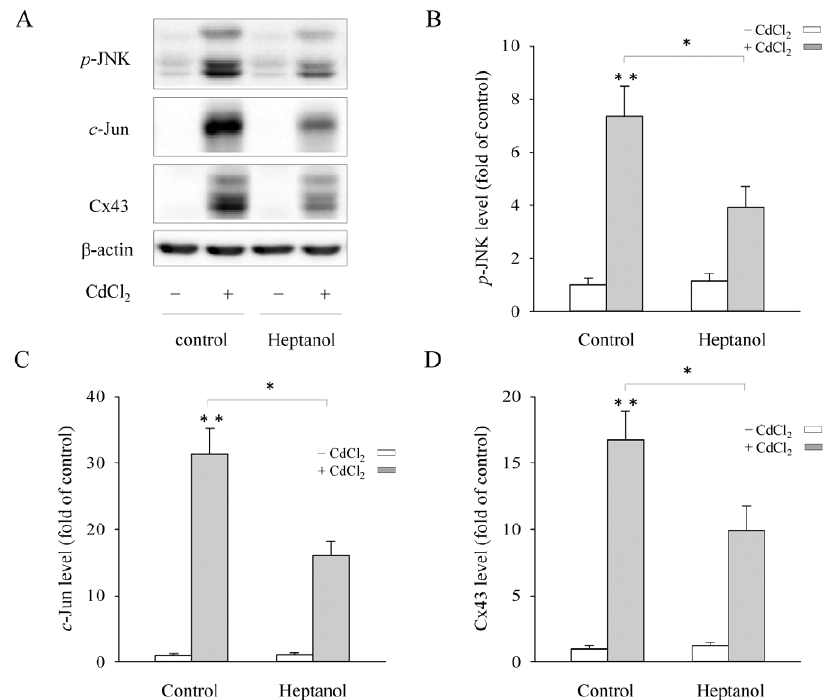
Figure 4. Influence of gap junctions (GJs) blocker on Cx43 expression and JNK activation. (A) Cx43-LLC-PK1 cells were pretreated with GJs blocker, 4 mM heptanol for 30 min before exposing them to 35 m M Cd 2 + for 6 h. Cellular proteins were analyzed for p -JNK, c -Jun, Cx43 and b - actin. (B–D) Densitometric analysis of p -JNK, c -Jun and Cx43 expression shown in A. Results were expressed as relative induction compared with the basal level (mean 6 S.D., n=3). * p , 0.05 versus Cd 2 + alone, and ** , 0.01 versus untreated